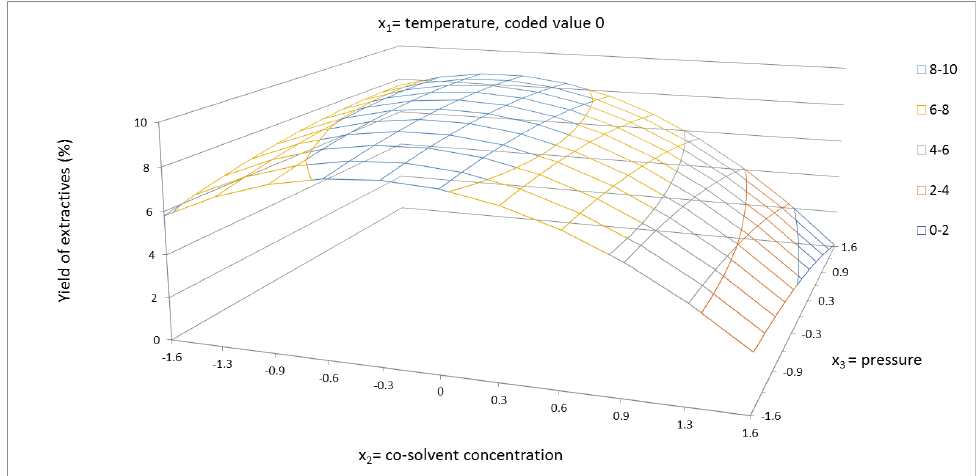
Figure 3. Response surface of extractives yield (%) as a function of cosolvent concentration of 40–96.6% EtOH / water and pressure in the range of 1050–9000 psi, in coded values, at constant temperature of 70 ◦ C (coded value 0).